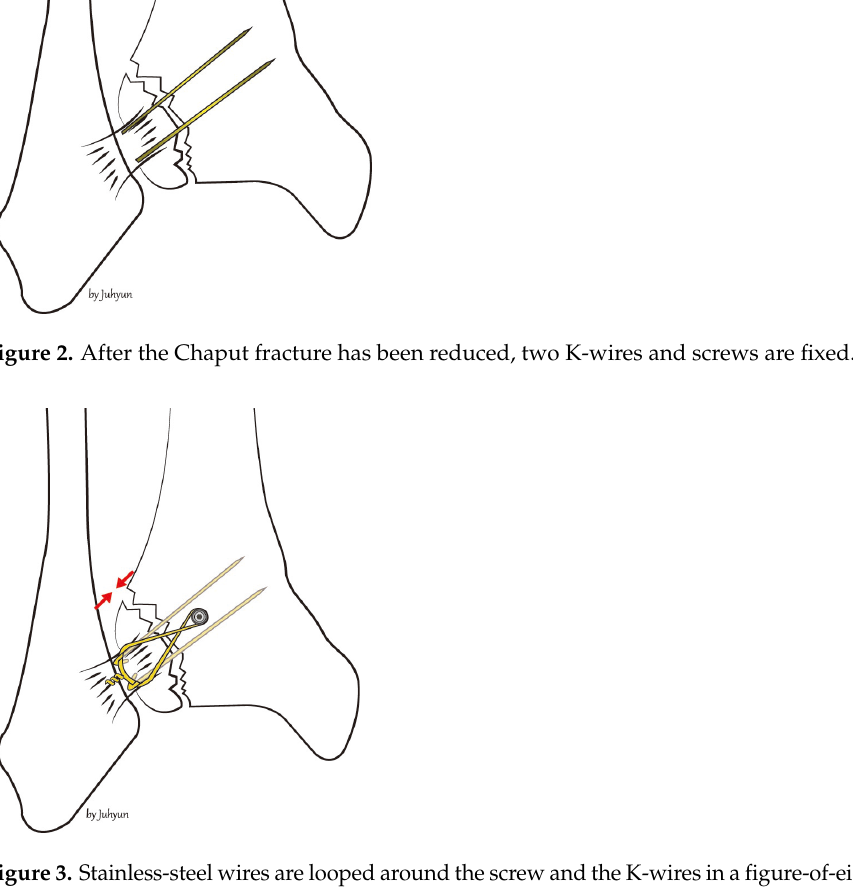
Figure 4. A postoperative, plain anteroposterior radiograph shows a Chaput fracture fixed using the new technique. Figure 5. Postoperative axial ( a ) and coronal ( b ) computed tomography images show that the Cha- put fracture exhibited good reduction, compression, and fixation (arrow).